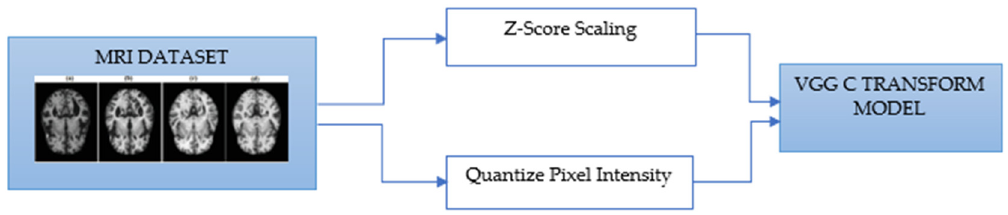
Figure 2. VGG-C Transform model process by MRI data.